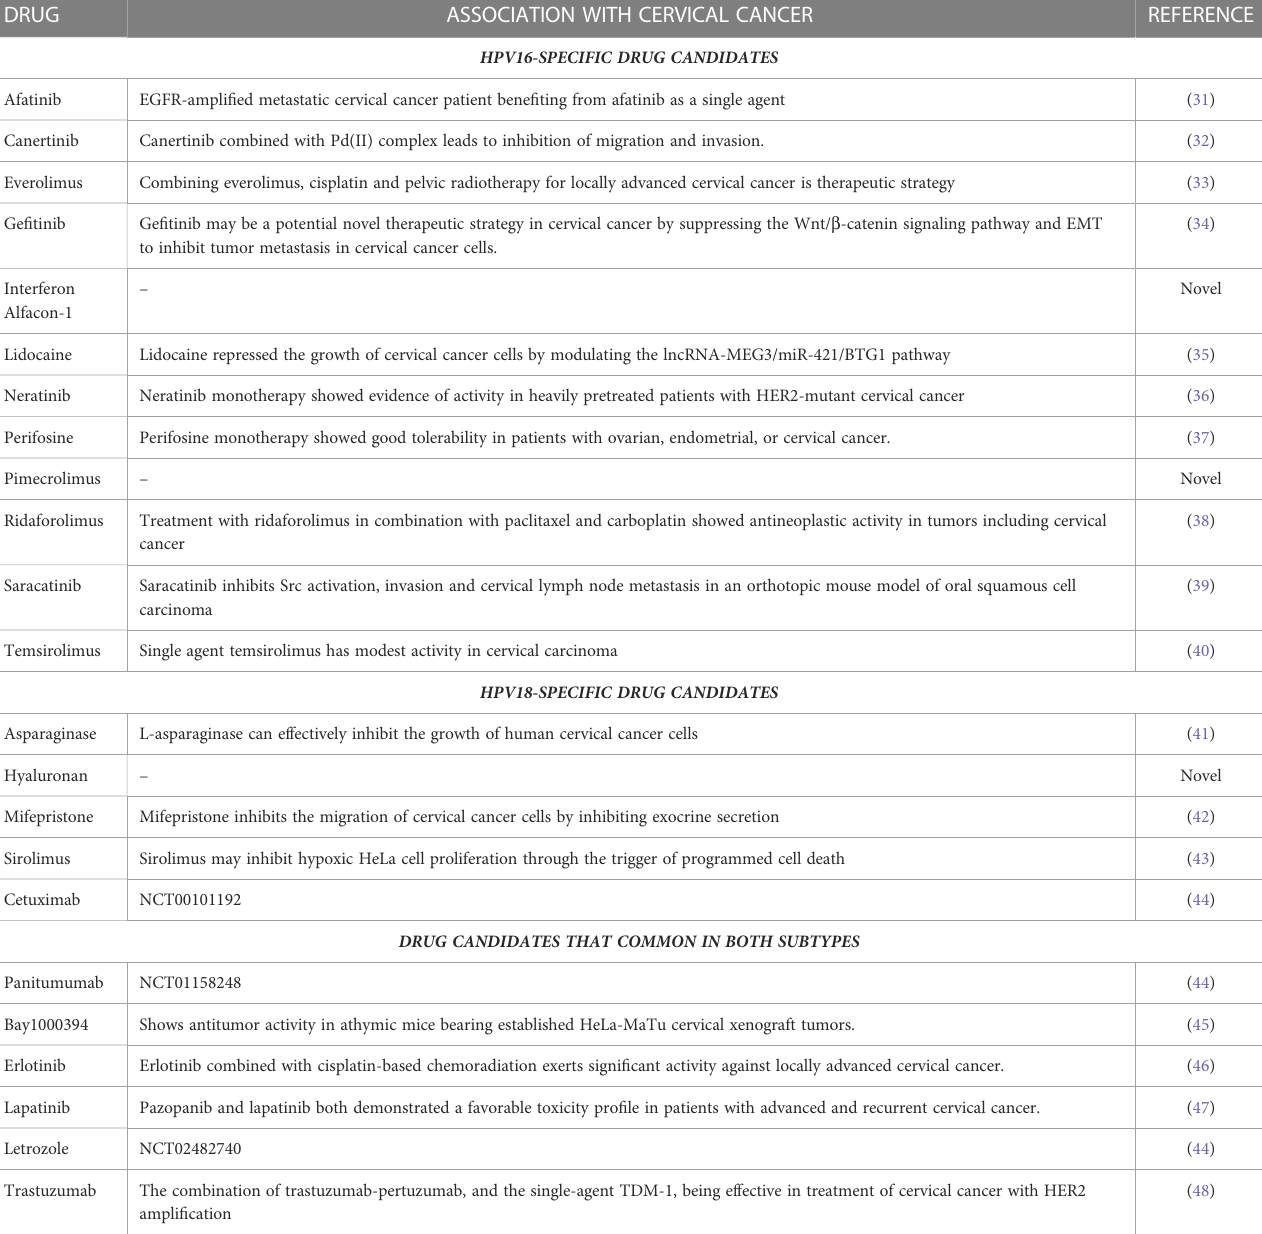
TABLE 1 The candidate drugs association with cervical cancer. DRUG ASSOCIATION WITH CERVICAL CANCER